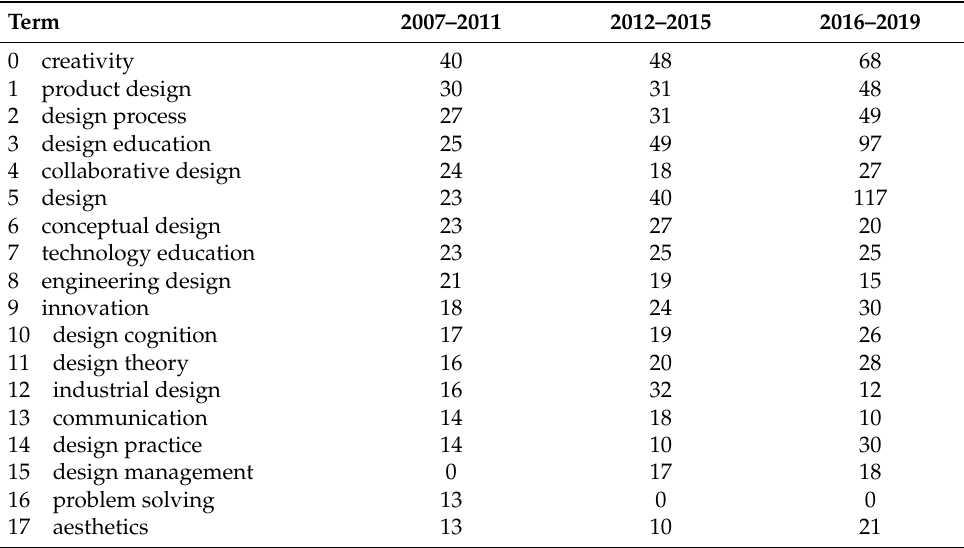
Figure 7. Research keywords distribution according to three-time spans. Table 3. Sample of terms distribution by the three